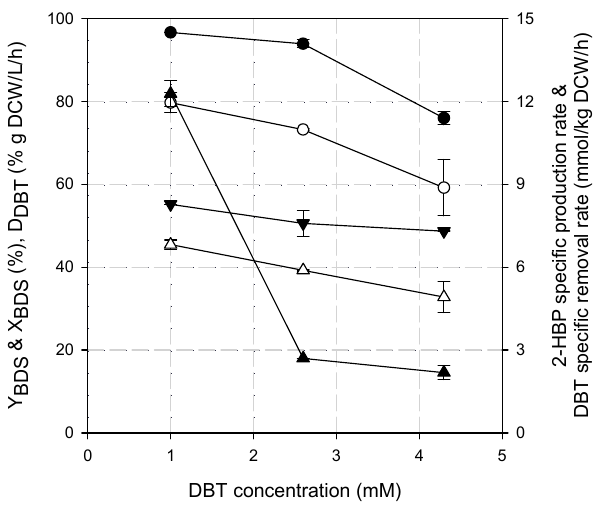
Figure 8. Biodesulfurization of DBT by R. erythropolis IGTS8 resting cells at different initial concentrations. Symbols : ( λ ) Y BDS (%), ( ◯ ) X BDS (%), ( π ) D DBT (% g DCW/L/h), ( △ ) specific 2-HBP production rate (mmol 2-HBP/kg DCW/h), and ( θ ) specific BDT removal rate (mmol/kg DCW/h).